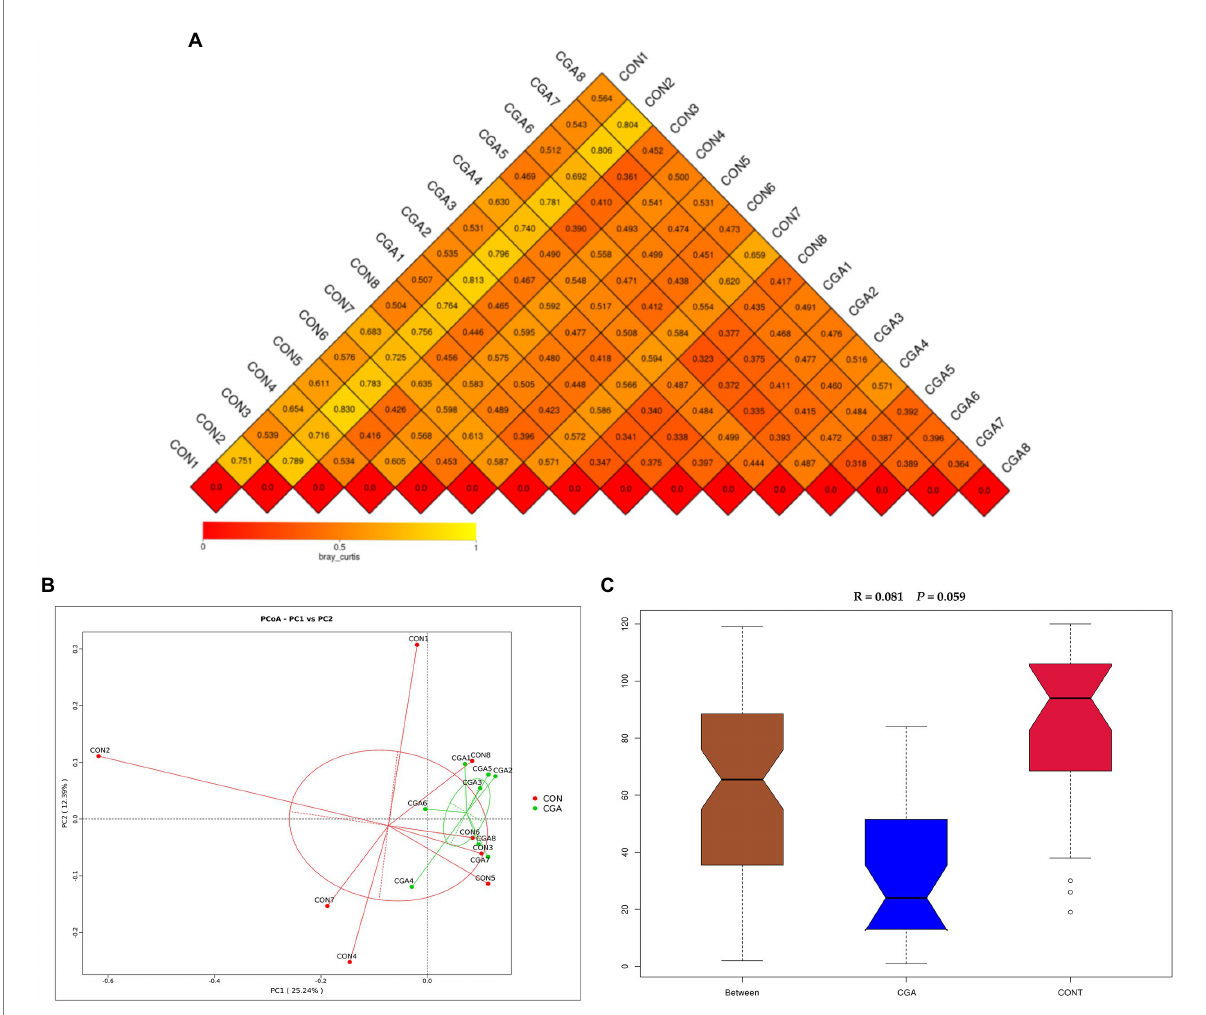
FIGURE 6 Beta diversity of microbial community analysis. (A) Heat-map of beta diversity for each two samples in the two groups by weighted Unifrac distance. (B) The principal coordinate analysis (PCoA) profile of weighted Unifrac distance. (C) Analysis of ANOSIM. R value is scaled to lie between − 1 and + 1. Generally, 0 < R < 1 and p < 0.05 represents that there were significant differences between the groups. CON, rabbits fed a basal diet; CGA, rabbits fed the basal diet supplemented with 800 mg/kg chlorogenic acid. n =